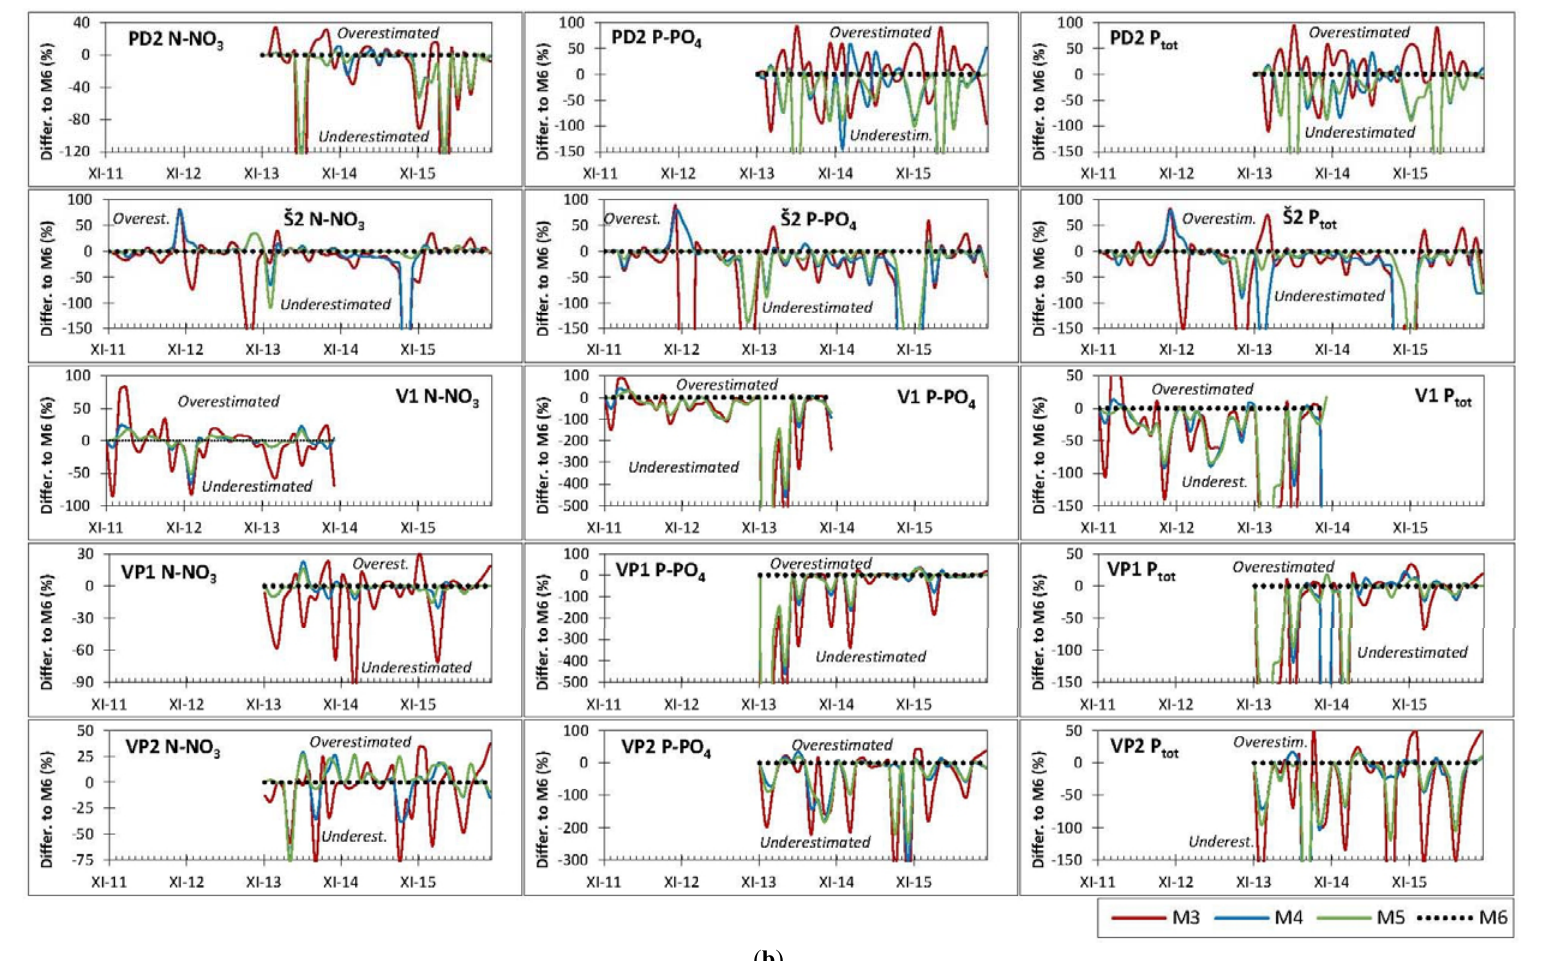
Figure 7. ( a ) Monthly values of accuracy (%) of M3 to M5 related to M6 for all substances at sites KL, KP, P53, P6, and PD1 and for all monitored periods. ( b ) Monthly values of accuracy (%) of M3 to M5 related to M6 for all substances at sites PD2, Š2, V1, VP1, and VP2 and for all monitored periods.